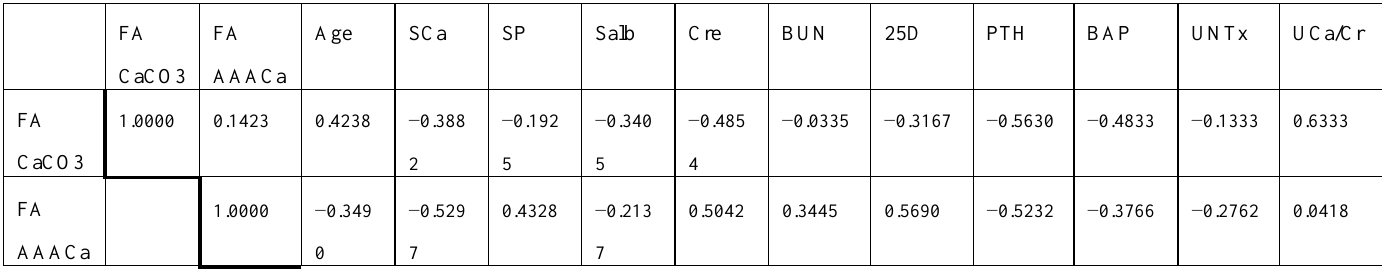
Table 5. Spearman’s correlation matrix and correlation coefficients among fractional absorption (FA) and parameters of bone and mineral